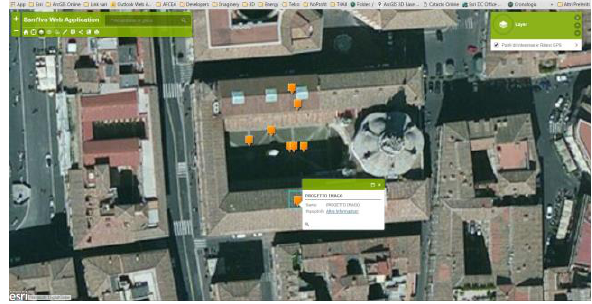
Figure 14. Web application published in ArcGIS Online